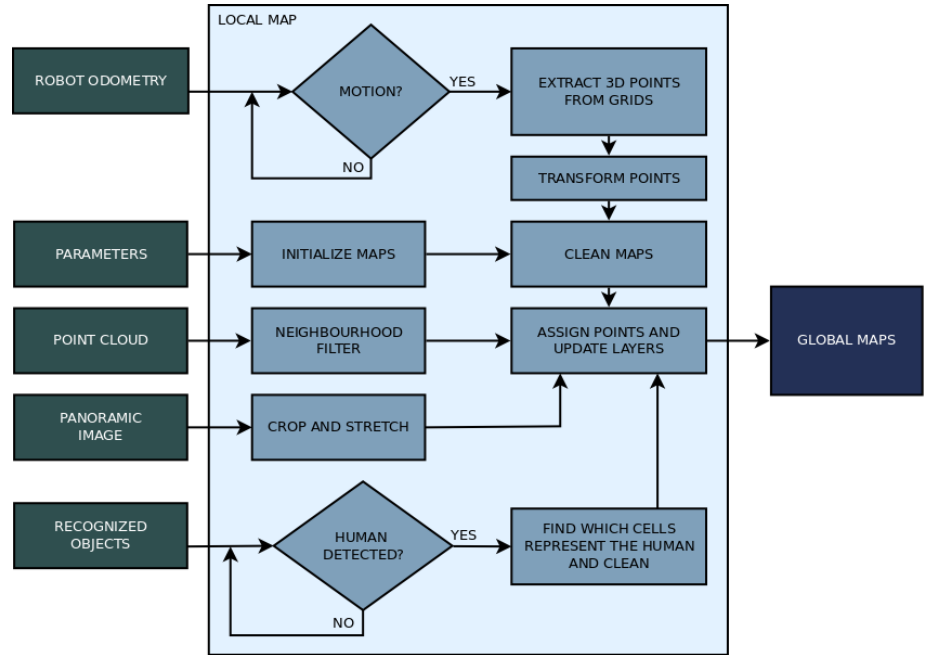
Figure 7. Flow chart of the processes involved in building the local map.